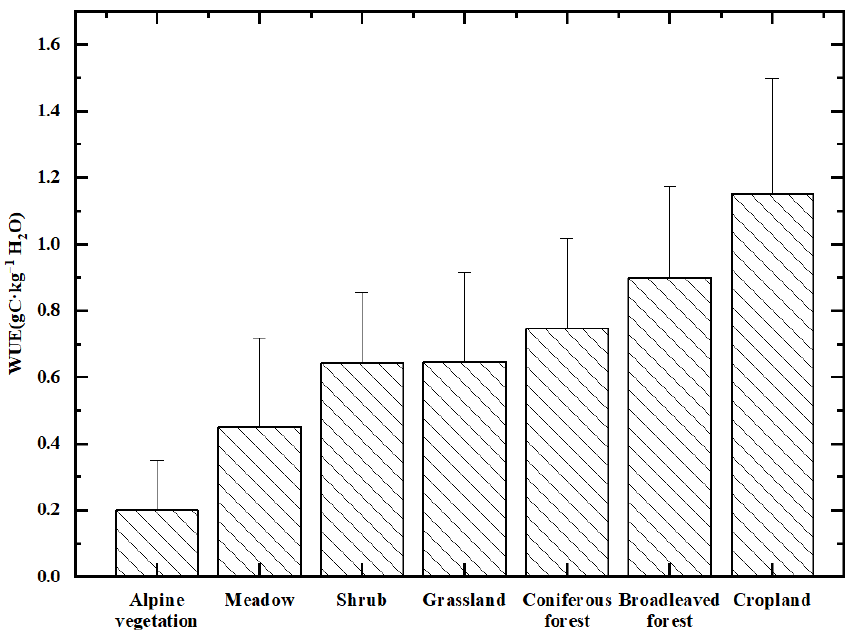
Figure 6. Comparison of multi-year average WUE of different vegetation